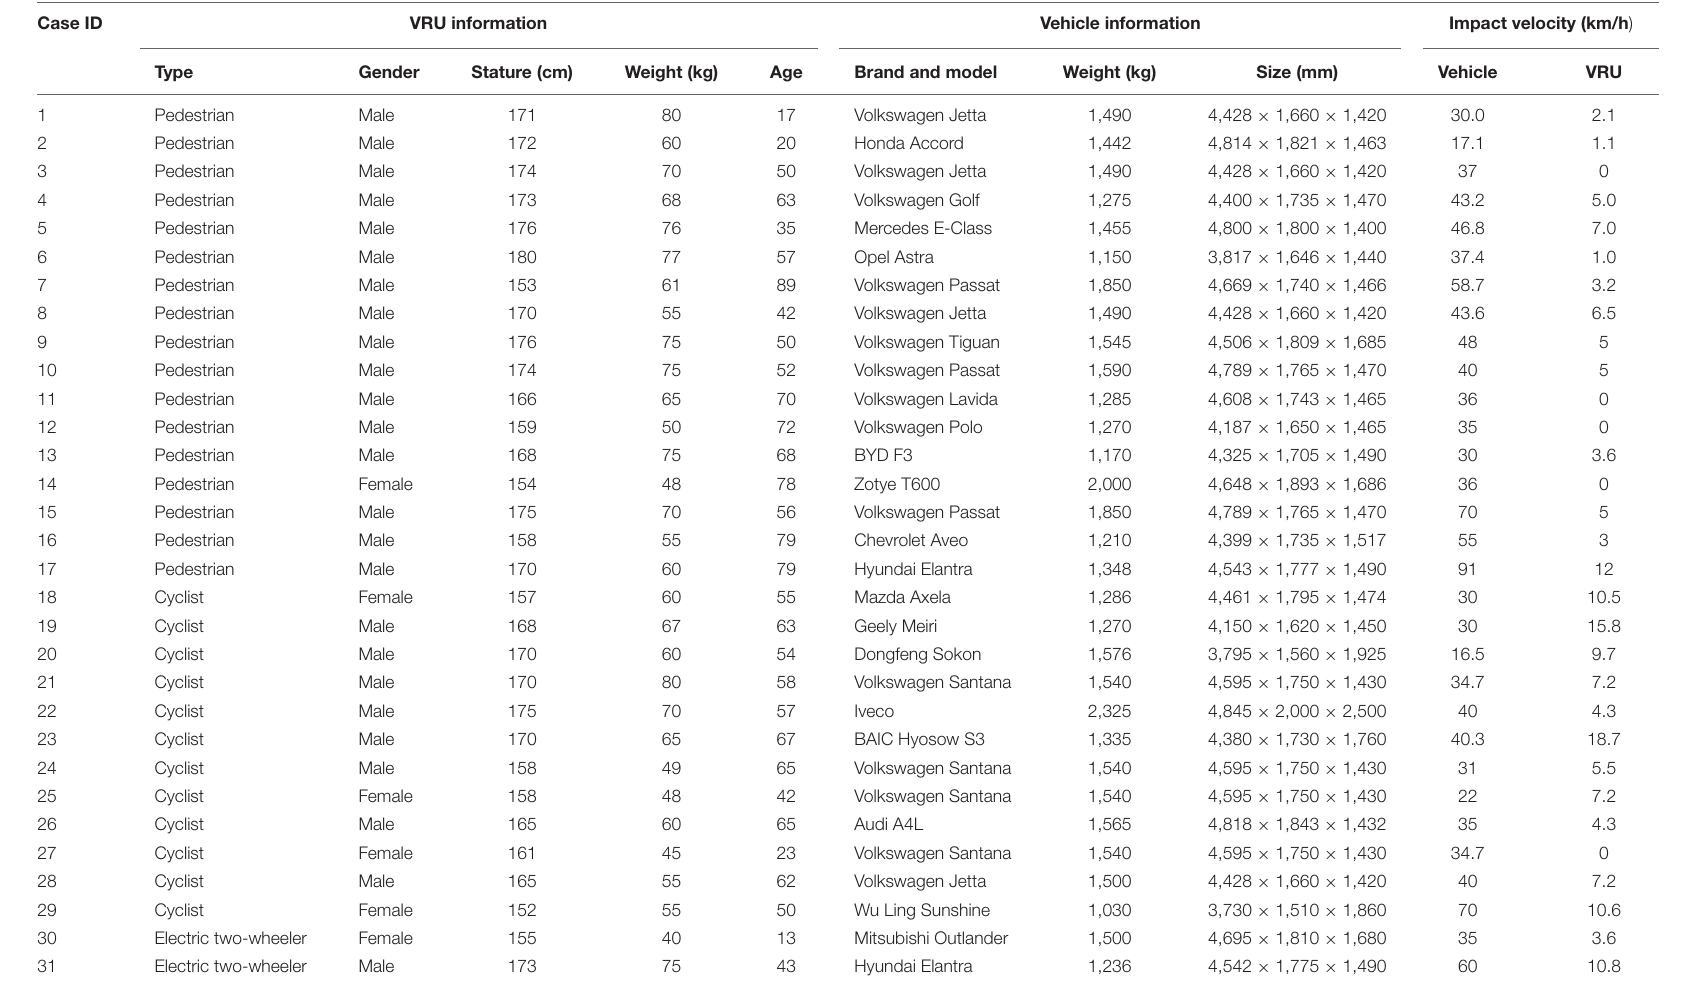
TABLE 1 | Basic information of 31 road traffic accidents selected for this